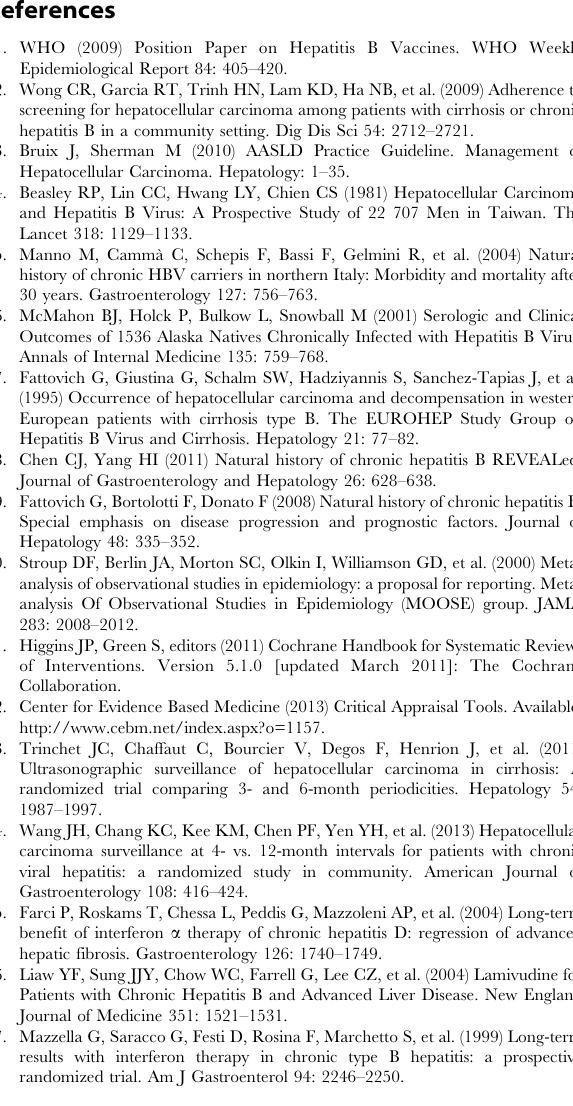
Table S2 Supplementary table, HCC incidence and mortality in included